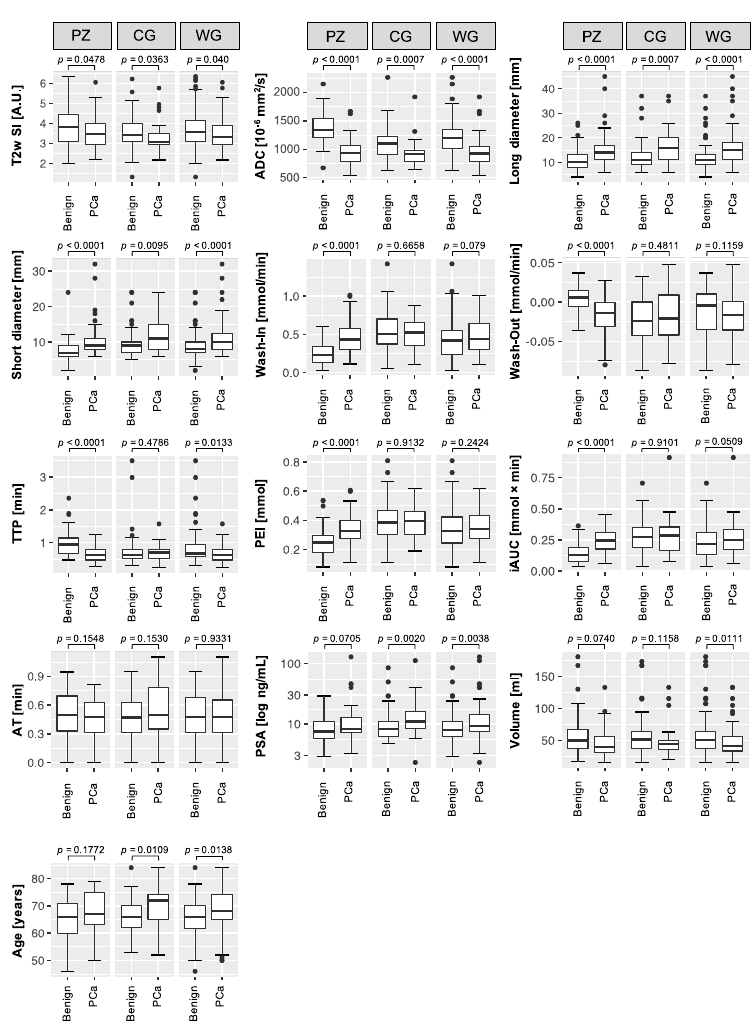
Figure 2. Boxplots of the acquired parameters. T2w signal intensity (SI), apparent diffusion coefficient (ADC), long and short diameter, dynamic contrast enhancement wash in and wash out, time to peak (TTP), peak enhancement intensity (PEI), initial area under the curve (iAUC), and arrival time (AT), and the additional parameters: prostate specific antigen (PSA) serum level, prostate volume, and patient age. Boxplots follow Tukey’s definition, with whiskers depicting the 1.5× interquartile ranges, and outliers marked as circles. The plots compare benign lesions (left boxes) with prostate cancer (PCa) lesions (right boxes), further divided into analyses of the whole gland (WG), and sub-analyses of the peripheral zone (PZ) and the central gland (CG). p -values, derived from Mann–Whitney U tests, are given above the plots.